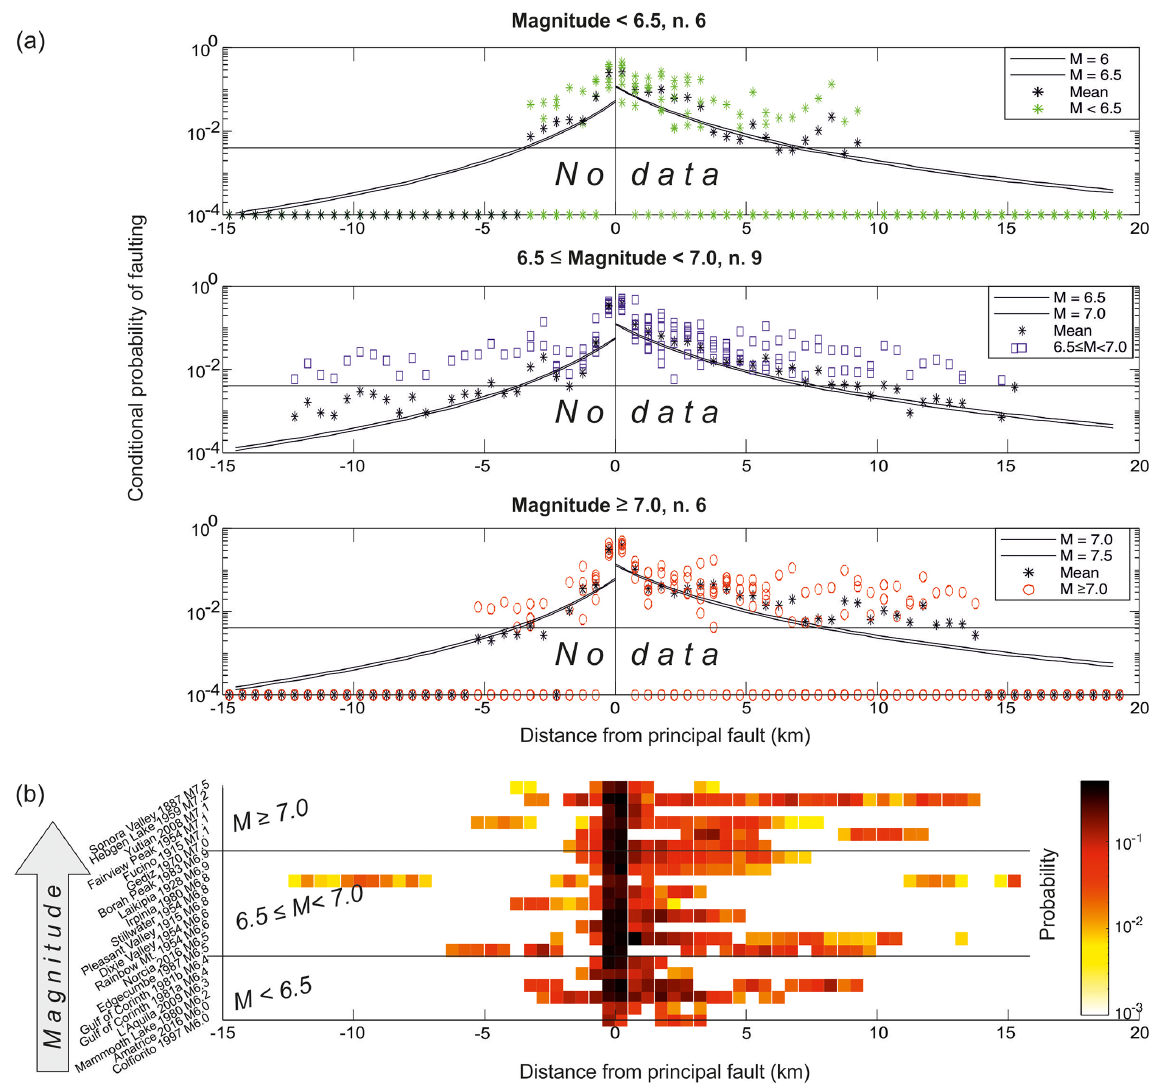
Figure 3. (a) Conditional probability of faulting as a function of distance from the principal fault. Earthquakes are grouped according to their magnitude ( M < 6 . 5; 6 . 5 ≤ M < 7 . 0; M ≥ 7 . 0); colored symbols represent the values for each earthquake and distance class, and black asterisks represent the mean values. Black lines are the scaling relations from Youngs et al. (2003; their Eq. 7). The “No data” field illustrates the region where no empirical observations are present, and probabilities are extrapolated by fitting. (b) Comparison between the 21 earthquakes, ranked according to magnitude; each line represents a single